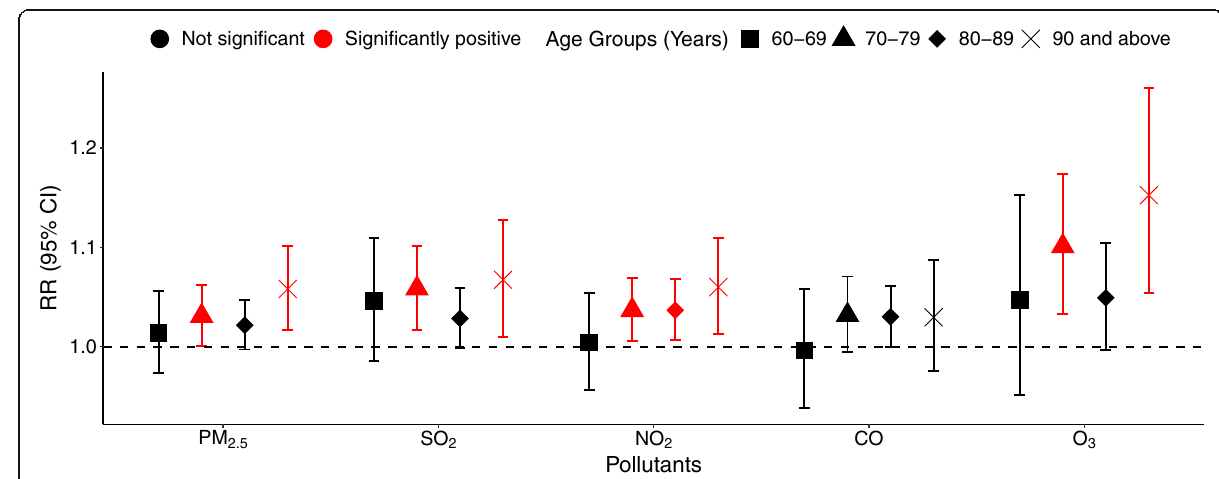
Fig. 4 Associations between IQR increases in PM 2.5 , SO 2 , NO 2 , CO, and O 3 and COPD-related mortality among different age